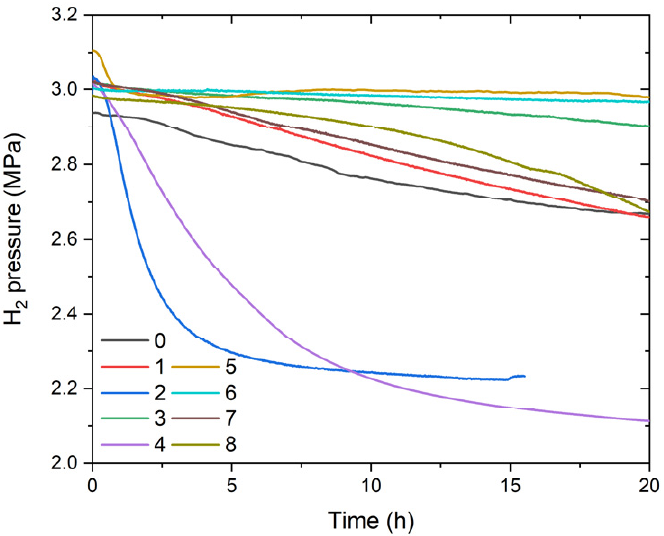
Figure 6. First-cycle activation profile for samples 0–8. The hydrogen pressure inside the closed reactor was recorded for 20 h.